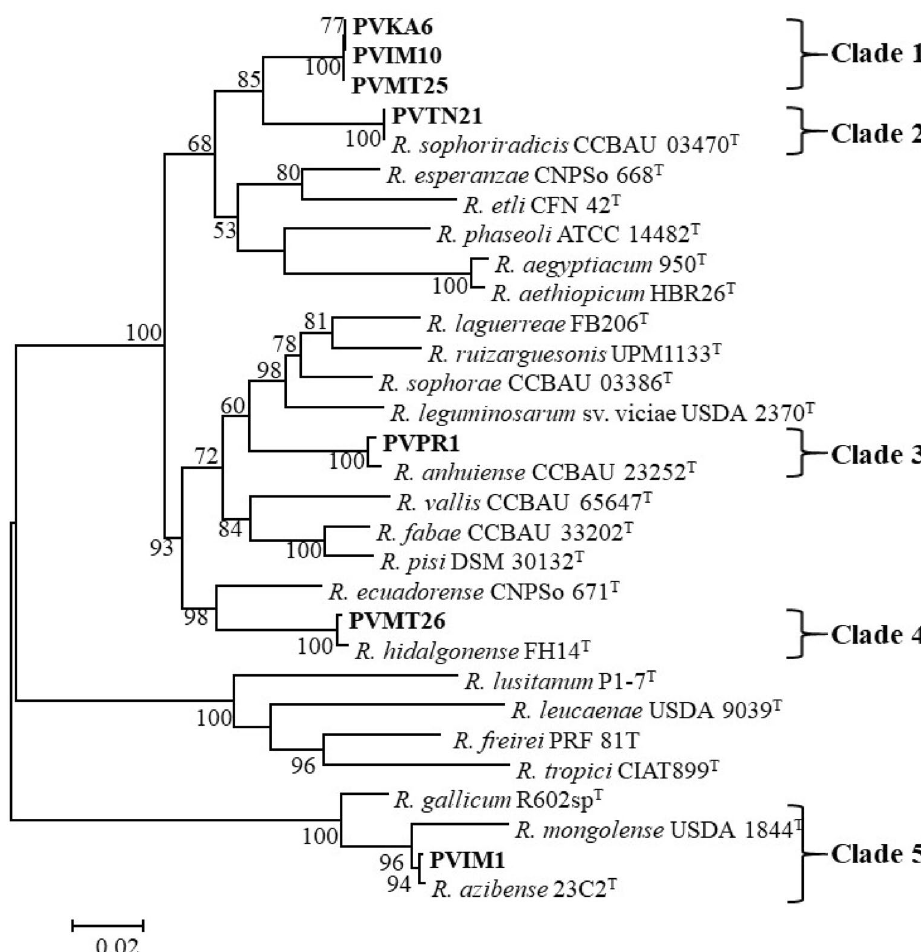
Figure 2. Maximum likelihood phylogenetic tree based on partial concatenated sequences of recA , atpD , gyrB, and glnII (with a total of 1962 positions) showing taxonomic relationships of the studied strains and representative related type species. Strains isolated in the present study are shown in boldface and type strains are indicated by superscript “T”. GenBank accession numbers of the sequences are given in Supplementary Figs. S3–S6 and Supplementary Table S2. Bootstrap values (greater than 50%) were calculated for 500 replications and are shown at the nodes. The scale bar shows the number of nucleotide substitutions per site. Phylogenetic analysis was conducted in MEGA 6 104 (https:// www. megas oftwa re. net/) using the